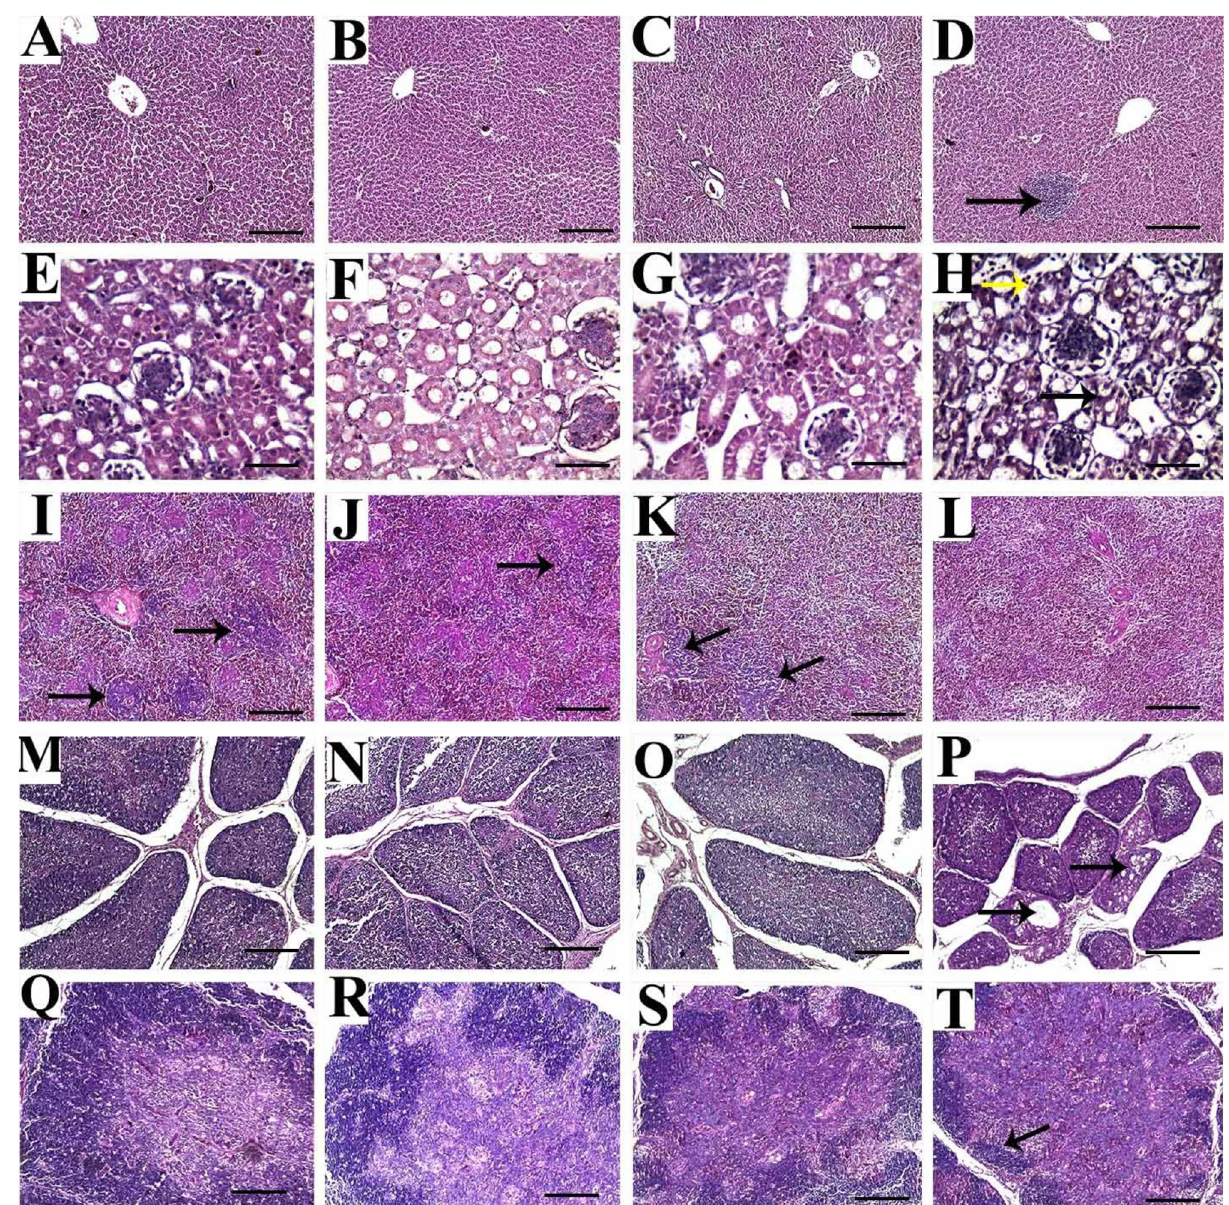
Figure 3. Representative photomicrographs for liver ( A – D ), kidney ( E – H ), spleen ( I – L ), bursa of Fabricius ( M – P ) and thymus ( Q – T ) of broiler chickens treated with different levels of SiO 2 @AgNPs for 35 days; H&E stain; bar = 100 μm for liver, spleen, bursa, and thymus; bar = 100 μm for kidney. Chickens from control group ( A , E , I , M , Q ); chicken treated with 2 mg of SiO 2 @AgNPs ( B , F , J , N , R ); chicken treated with 4 mg of SiO 2 @ AgNPs ( C , G , K , O , S ); chicken treated with 8 mg of SiO 2 @AgNPs ( D , H , L , P , T ) showed: healthy normal liver tissue with no specific lesion ( A – C ); multifocal accumulations of mononuclear cells (arrow) ( D ); histologically normal structure of renal tubules, renal epithelium, and glomerulus ( E – G ); mild intertubular hemorrhage and vacuolization of lining renal epithelium (arrows) ( H ); normal histologic limits of white and red pulps and lymphoid follicles (arrows) ( I ); reduced size of lymphoid follicles (arrow) ( J ); few lymphoid follicles (arrows) ( K ); complete absence of lymphoid follicles ( L ); normal histologic structure of bursa with normal size and number of follicles and normal intensity of lymphocytic populations within medulla and cortex ( M – O ); reduced size and number of follicles, reduced medullary cell populations, and frequent cystic structure formation in some bursal follicle (arrows) ( P ); normal histologic structure with normal intensity of medullary and cortical thymocytes and distinct corticomedullary junction ( Q – S ); marked loss of cortical basophilic thymocytes and congested medullary vessels (arrows) ( T